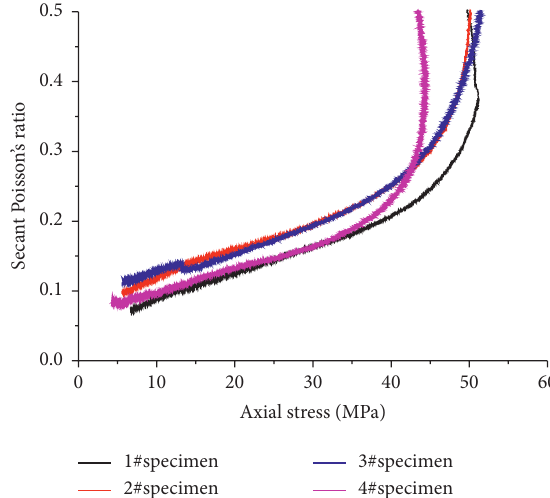
Figure 7: Secant Poisson’s ratios of several marble